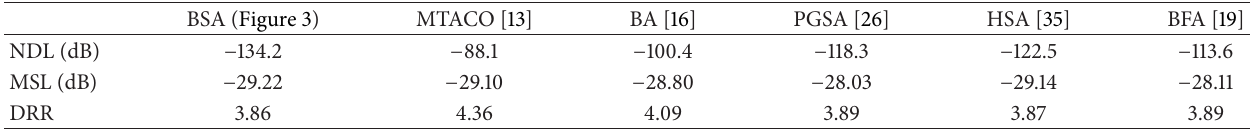
Table 1: NDL, MSL, and DRR values obtained by BSA and other optimization techniques MTACO [13], BA [16], PGSA [26], HSA [35], and BFA [19] for one null imposed at 14 ∘ .